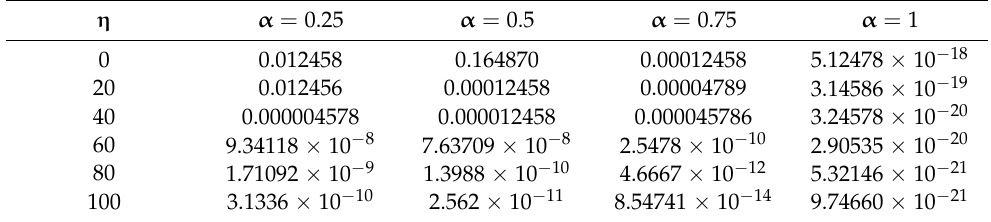
(cid:16) (cid:101) h ( η , t )